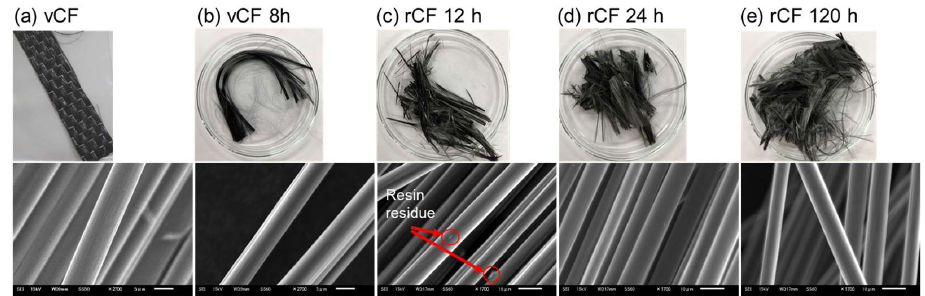
Figure 3. SEM images of the carbon fiber surface of ( a ) vCF, ( b ) vCF 8 h, and rCF ( c ) 12 h, ( d ) 24 h, and ( e ) 120 h.